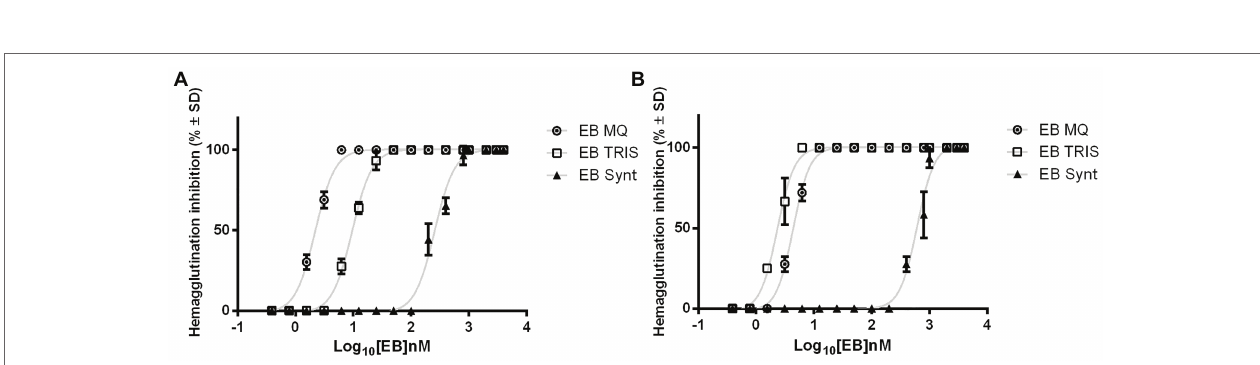
FIGURE 6 | EB blocks the binding of viral hemagglutinin to its receptor. EB expressed in microalgae and synthetic EB inhibited the viral hemagglutination. Dose- response curves of each peptide show the ability of EB to prevent viral hemagglutinin binding to sialic acid in red blood cell membrane. (A) EB inhibitory effects vs. influenza pdm A/H1N1 strain. (B) EB inhibitory effects vs. influenza A H1N1 Virginia/ATTC/2009 strain. The graph shows the mean hemagglutination inhibition in percentage for each EB ± SD. The results belong to three independent assays. (MQ): Milli Q water extracts; (TRIS): Tris Buffer